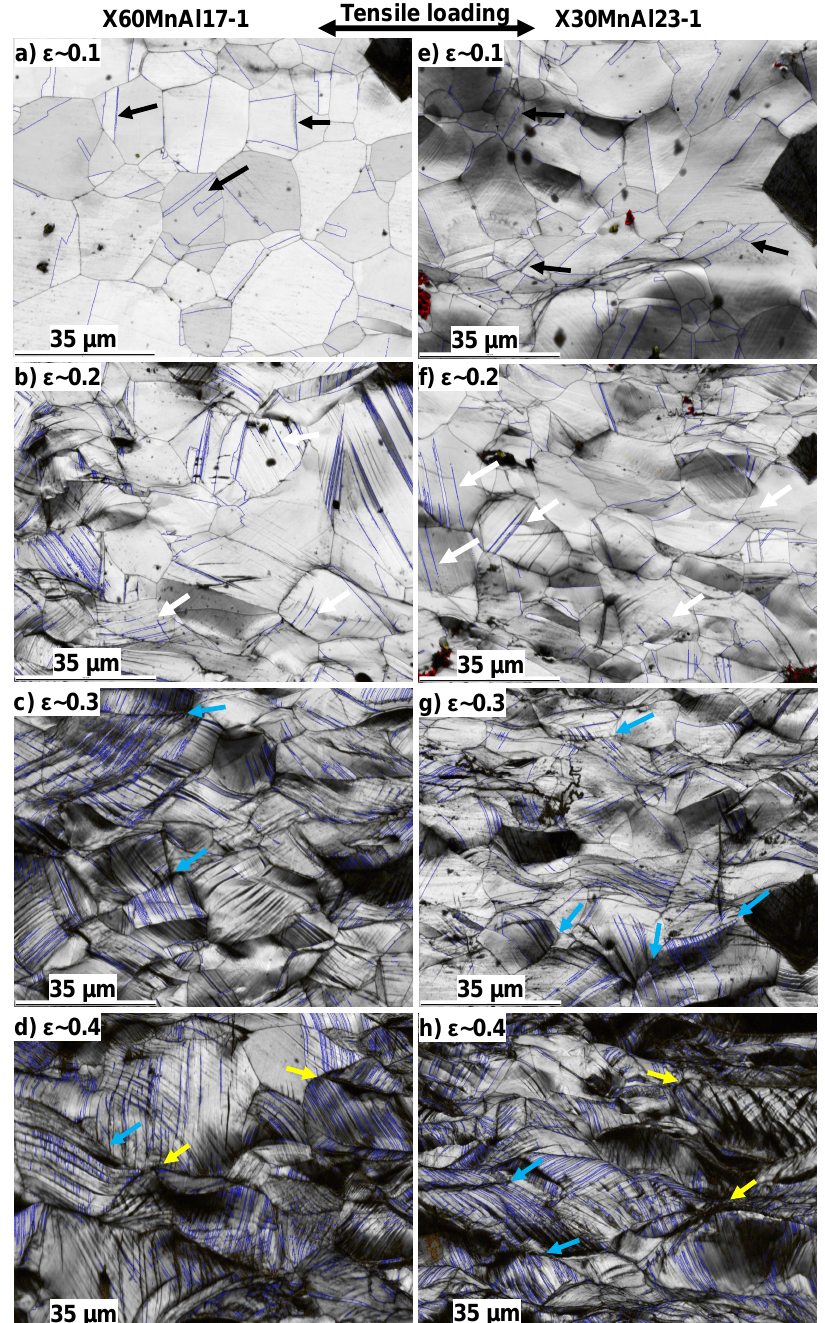
Figure 5. EBSD image quality (IQ) maps depicting the evolution of twinning with increasing macroscopic strain: X60MnAl17-1 ( a ) ε ∼ 0.1 ( b ) ε ∼ 0.2 ( c ) ε ∼ 0.3 ( d ) ε ∼ 0.4 (left column), X30MnAl23-1 ( e ) ε ∼ 0.1 ( f ) ε ∼ 0.2 ( g ) ε ∼ 0.3 ( h ) ε ∼ 0.4 (right column); blue color in IQ maps in ( a , e ) indicates annealing twin boundaries and detected Σ -3 deformation twin boundaries in ( b – d , f – h ); The arrows indicate annealing twin boundaries (black), nucleation of deformation twins (white), intercepting twins at grain boundary (light blue) and triple junctions (yellow); pixels in black are unindexed